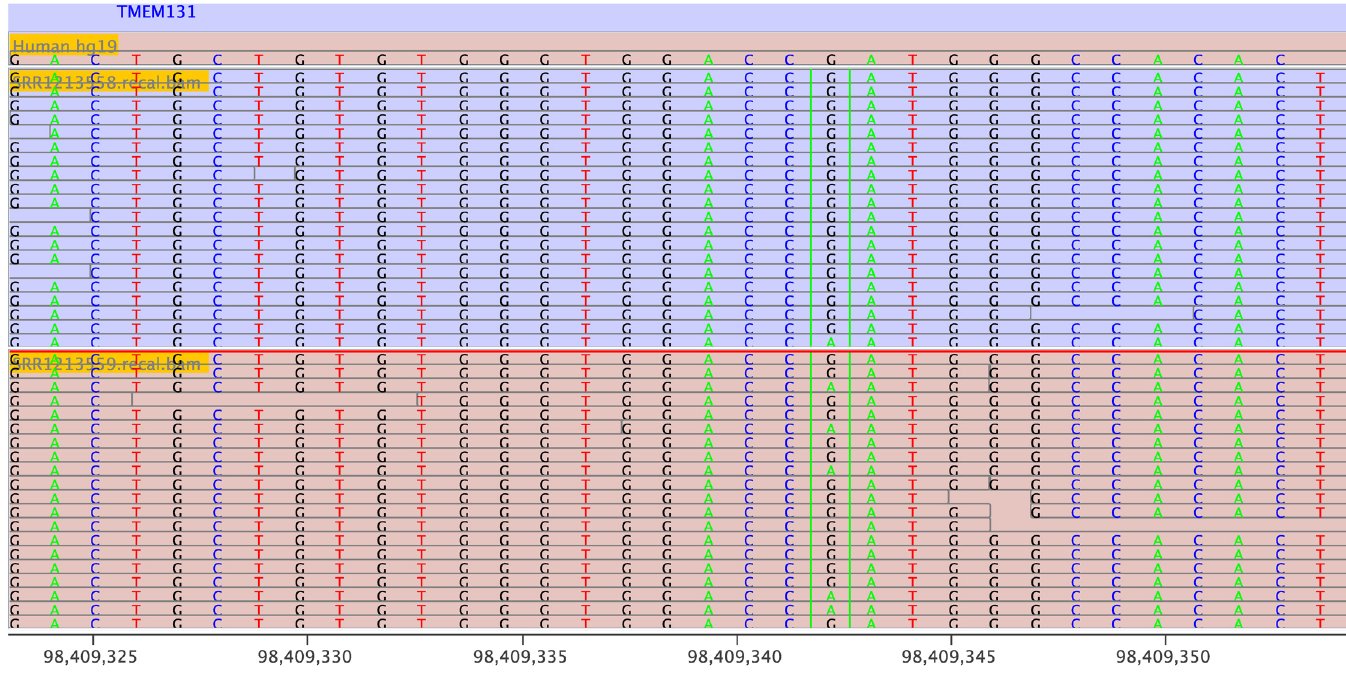
Fig 4. A RNA editing site (chr2:98409343) in TMEM131 is highlighted in the context of sequenced regions. A G ! A change (in the minus strand) was identified by RNA-seq. The upper panel (Run ID: SRR1213558) indicates a normoxia sample and the lower panel is for hypoxia sample (Run ID: